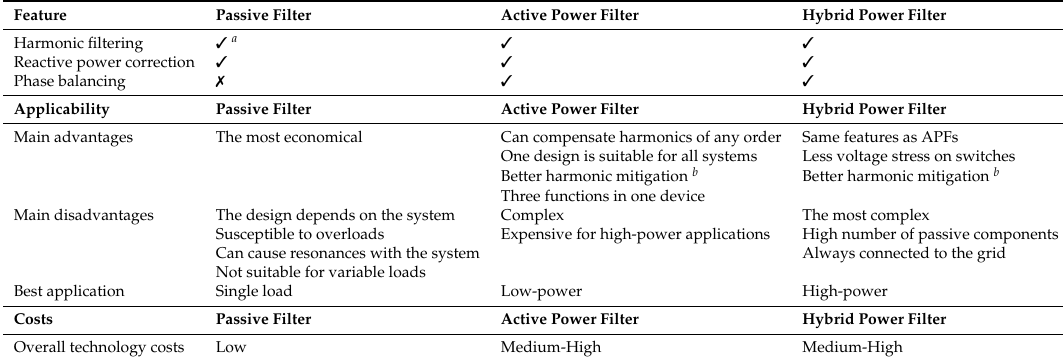
Table 7. Comparison of the main features of passive filters, active power filters, and hybrid filters for improving grid